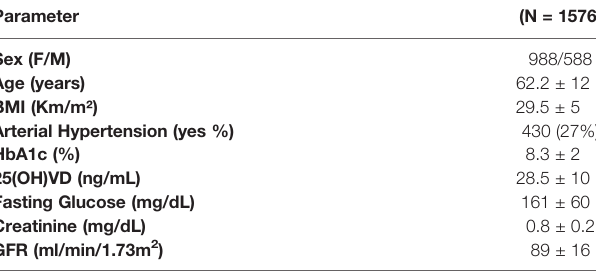
TABLE 1 | Patients ’ clinical and laboratory characteristics. Parameter